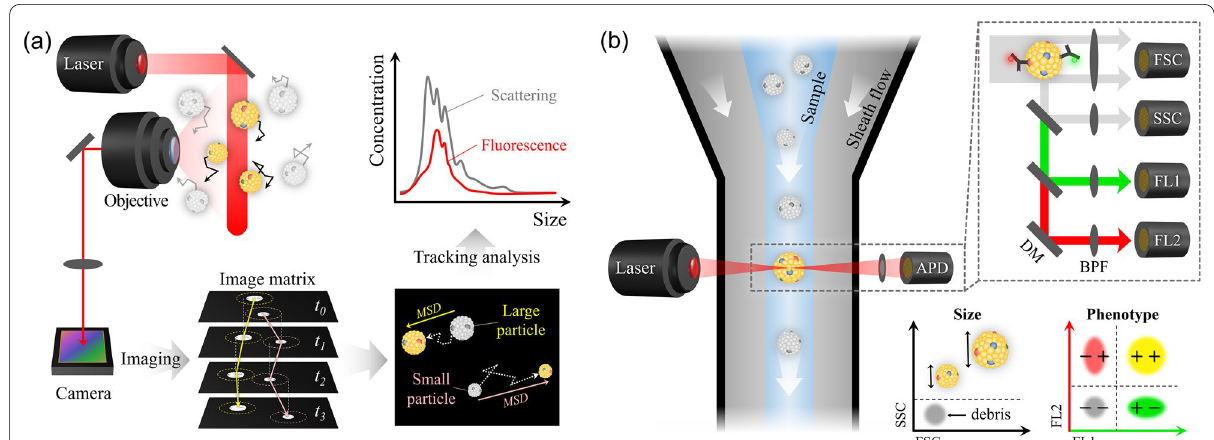
Fig. 2 Principle of optical analysis system for individual EVs. a Nanoparticle tracking analysis (NTA): diameter of particle is predicted according to mean square displacement (MSD) through Brownian motion of individual particles tracked for several frames. b nano-Flow cytometry (nFCM): the particle size is estimated by measuring the intensity of forward-scattered (FSC) and side-scattered (SSC) light in the flow of individual particles focused by the sheath